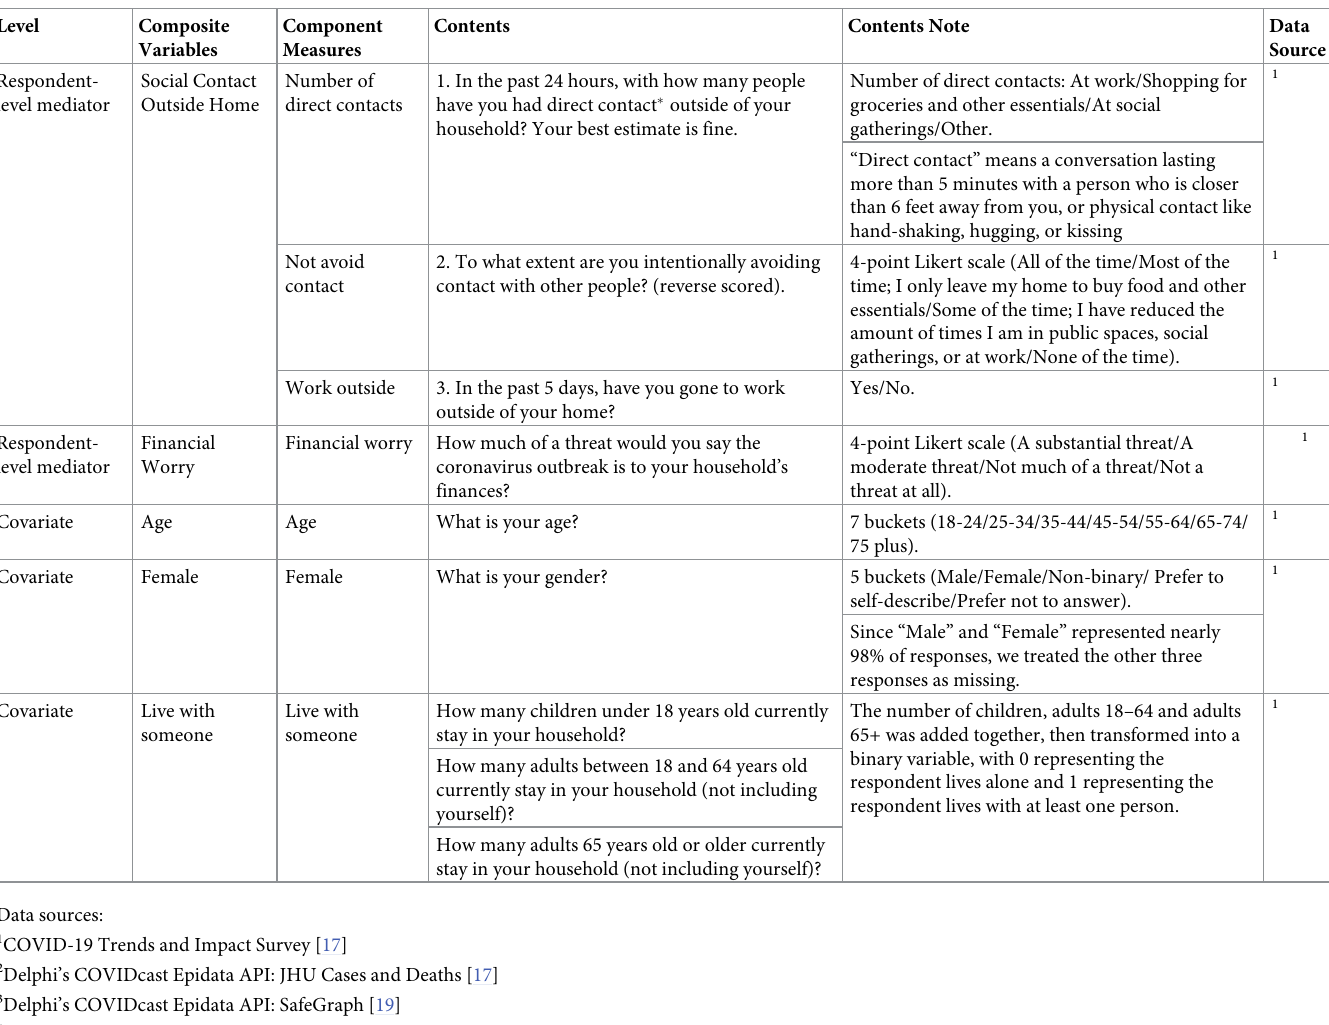
Table 4 also shows the direct effects of respondents’ demographics (age bracket, gender, and household composition) on their mental distress. The unit of analysis is a survey response. Because continuous variables have been standardized at the county level, the coefficients reflect the effects on respondents’ mental distress in standard deviation units resulting from a change of a binary predictor from zero to one (e.g., living alone to living with others) or the increase of a continuous variable by one standard deviation from its county-level base rate. Because of the very large sample size, all coefficients are reliably different from zero at the p < .0001 level. The structural equation mediation model is a good fit to the data (SRMR = .006), where an SRMR less than 0.08 indicates a good model fit [22]. Multicollinearity is not a problem, as all VIF values are lower than 2.5 (mean VIF = 1.1). Fig 3 shows both direct effects of county-level stressors on respondents’ mental distress and effects mediated by respondent-level worries about disease, social contact, and